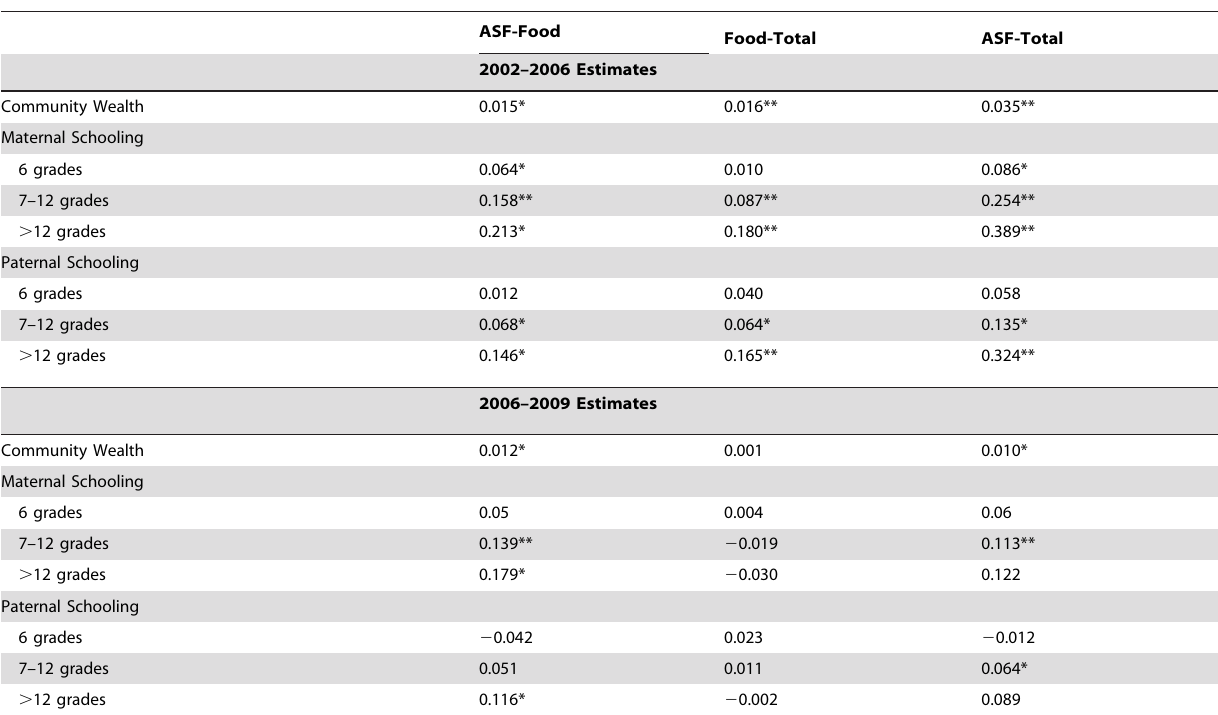
Table 3. Controls for Random Effects